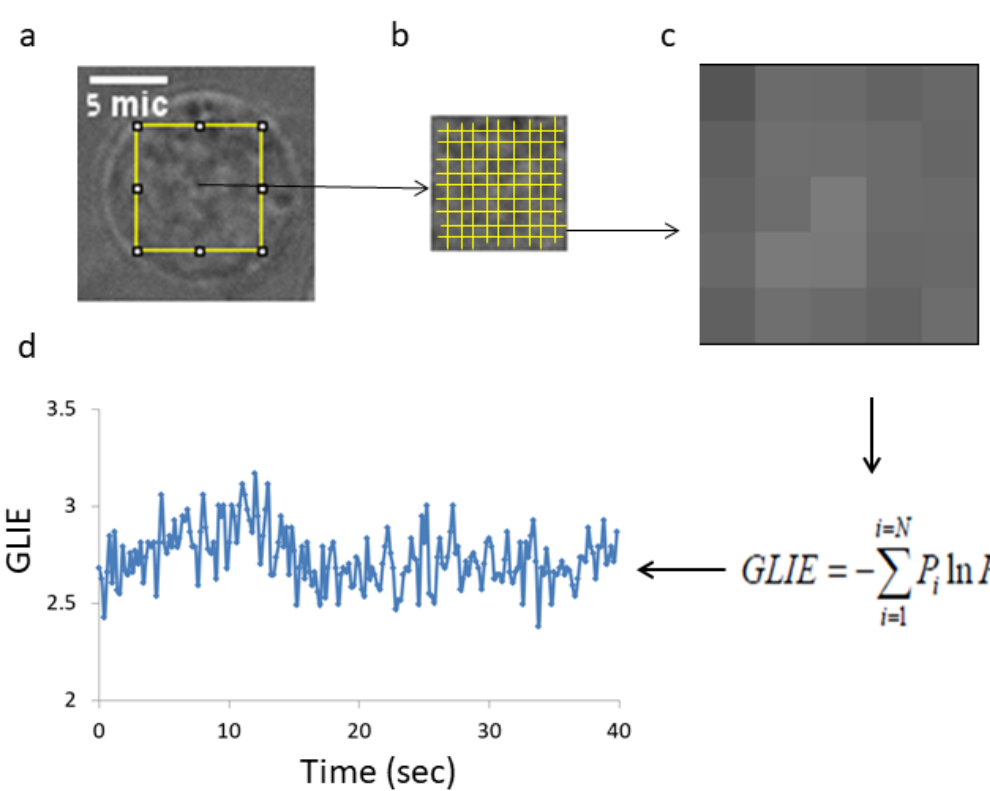
Figure 5. Capturing and analyzing GLIE fluctuations in an imaged cell. ( a ) An example of a Jurkat cell with the ROI of 50 × 50 pixels in its center. Serial 200 images in a time lag of 0.2 s were acquired for each cell. ( b ) The ROI of 50 × 50 pixels was divided to a 100 units of 5 × 5 pixels. ( c ) An example of distribution of gray levels in a unit of 5 × 5 pixels. ( d ) GLIE calculations according to the information entropy function in that 5 × 5 pixels unit for each time point out of the 200 serial acquisitions.